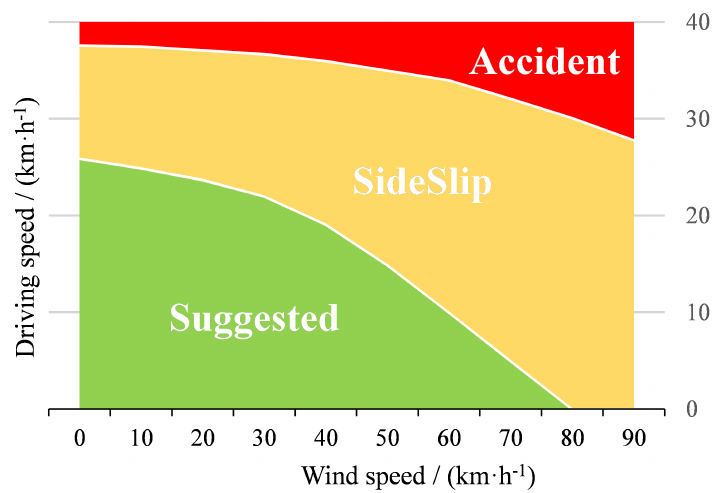
Figure 14. Critical driving speed of tractor-trailer under different crosswind